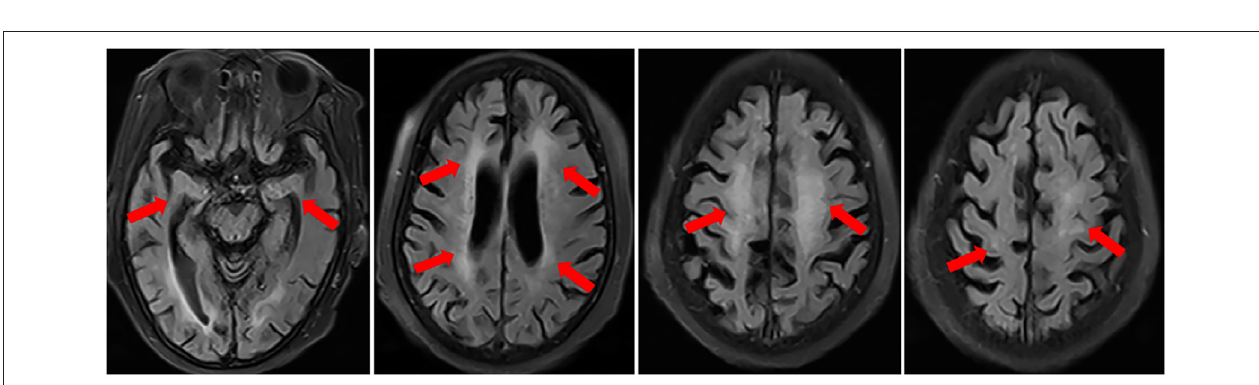
FIGURE 4 | Repeated brain MRI after 2 months of treatment in November 2019 showed the scattered foci of T2-FLAIR hyperintensity disappeared partially.